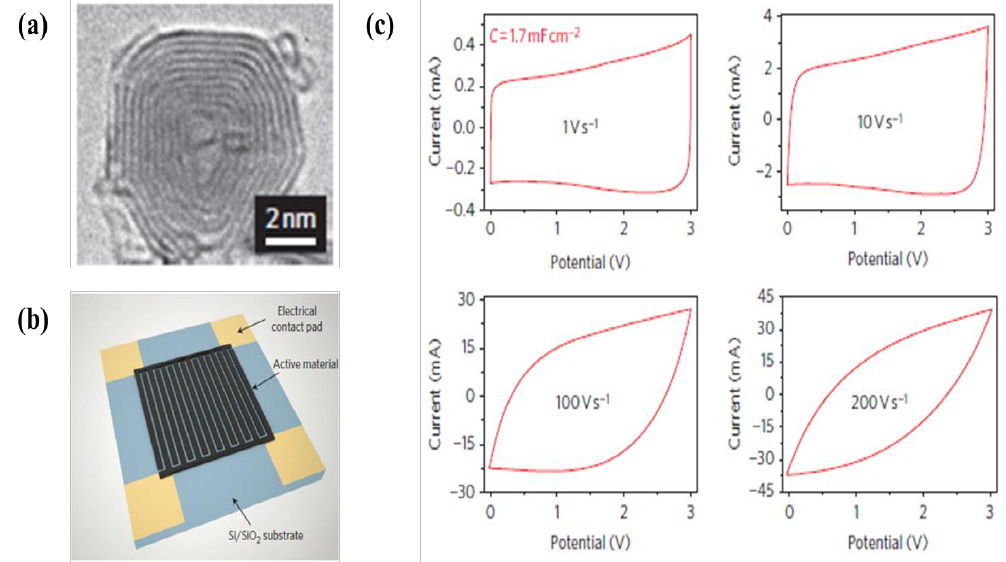
Figure 16. ( a ) TEM image of OLC produced at 1800 °C; ( b ) Schematic diagram of the micro-supercapacitor (25 mm 2 ); ( c ) CV scans at different scan rates for a micro-supercapacitor with 16 interdigital electrodes and tested in 1 M NEt 4 BF 4 in propylene carbonate (PC).